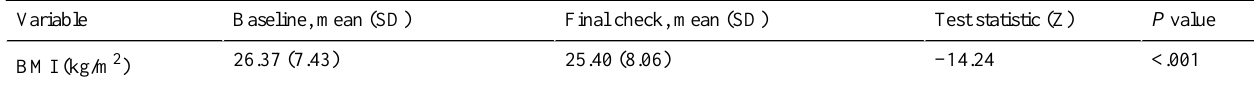
Table 4. BMI of repeat SiSU users at baseline compared with final check.